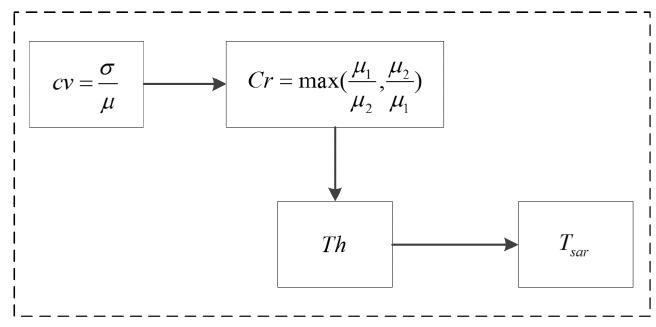
Figure 5. The flow chart of noise